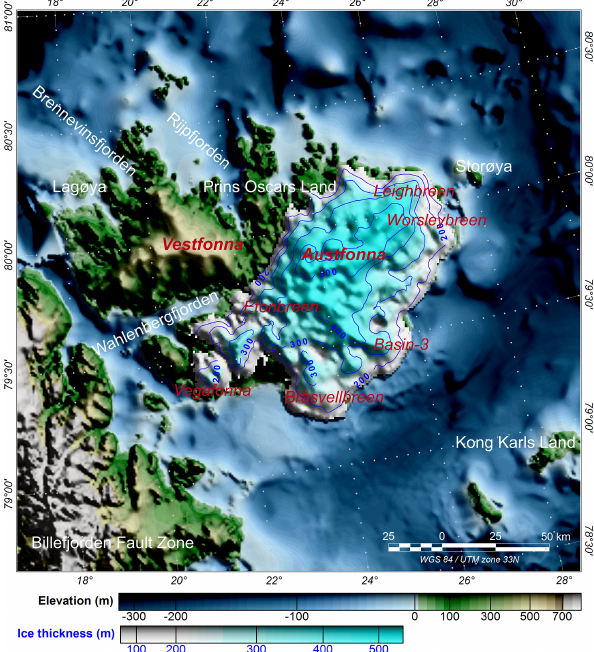
Figure 1. Surface topography map of Nordaustlandet, east of Spitsbergen, Svalbard, and the Austfonna icecap from Dunse et al. (2011). Approximately 80% of Nordaustlandet is covered by ice, and the ice thickness is up to ca. 600m. Polythermal and relatively flat at its highest elevation, Austfonna hosts both land-terminating and tidewater glaciers of which several have been observed to